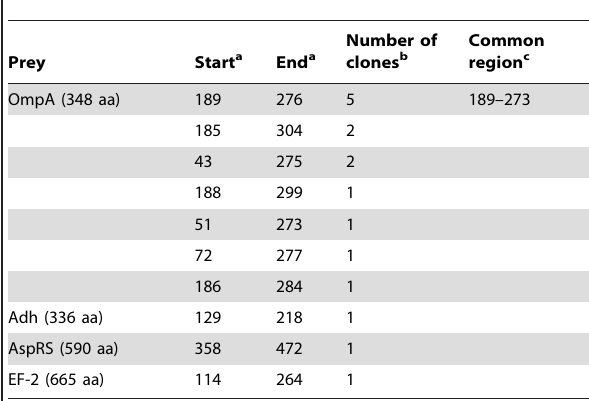
Table 1. Preys selected by the PhoN2 bait.